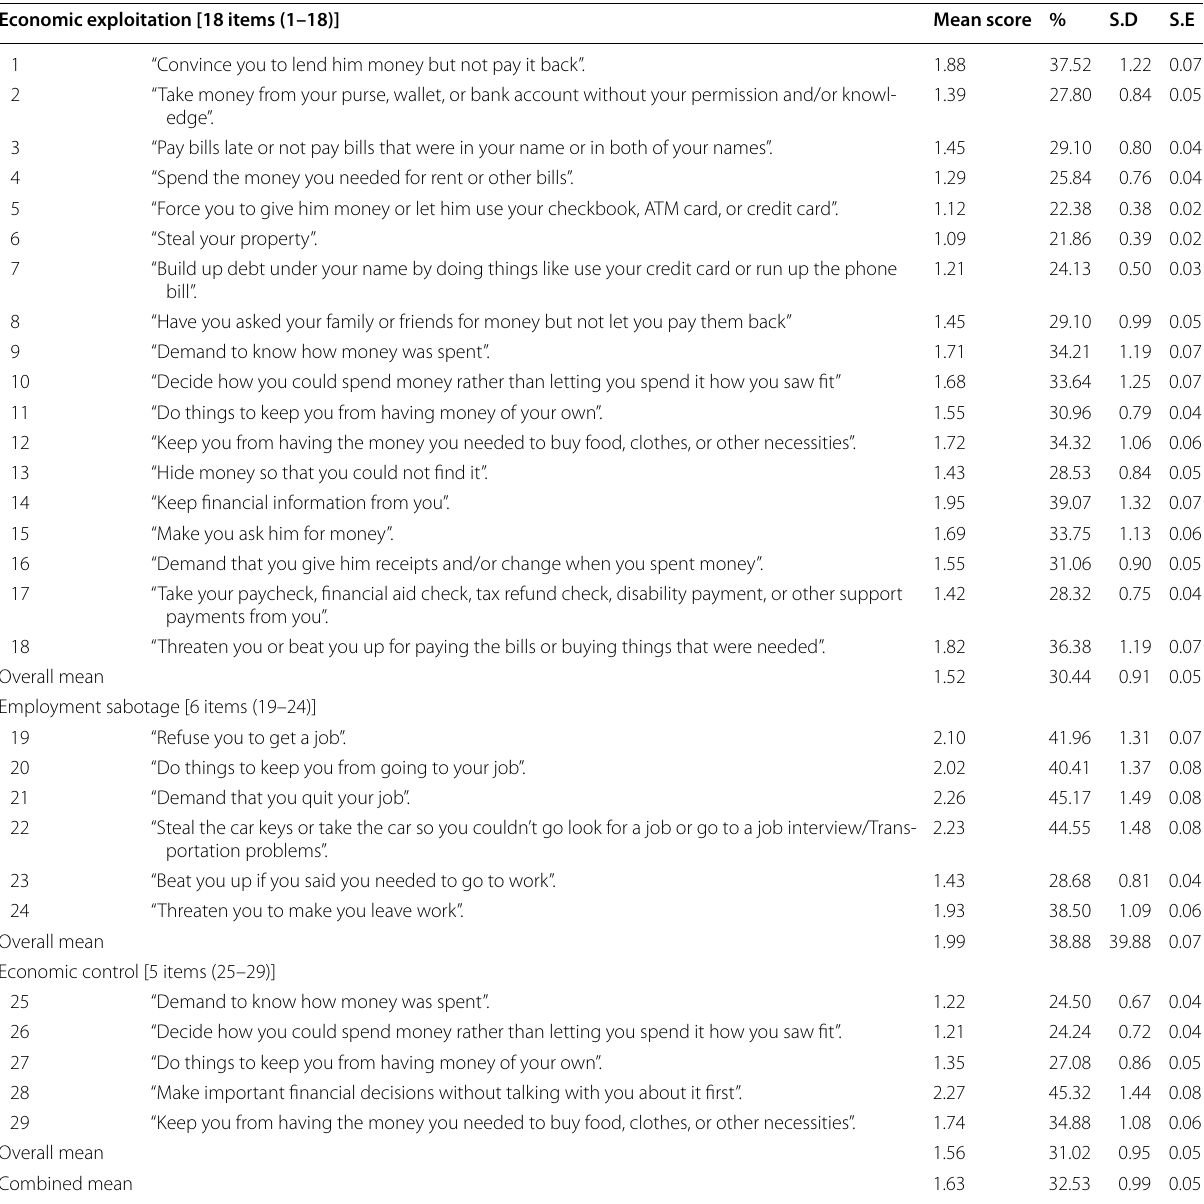
Table 1 Mean and percentage for scale of economic